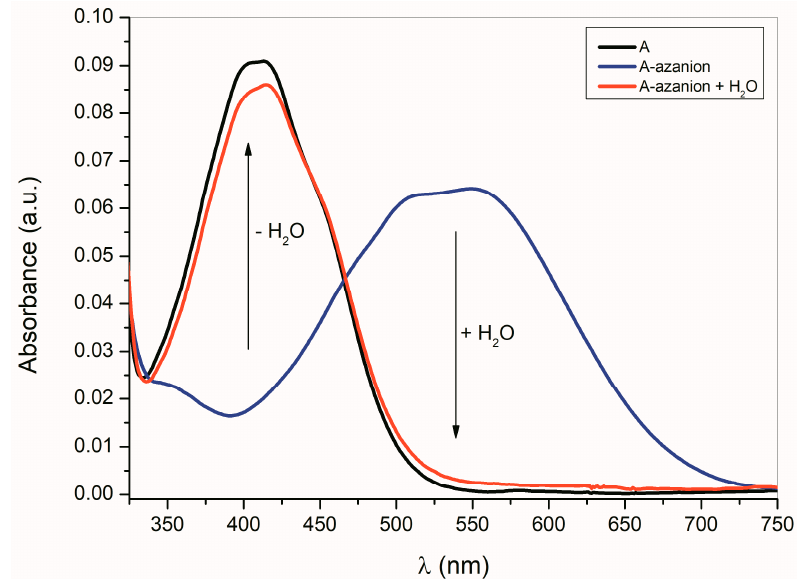
Figure 2. Effect of water (c H 2O = 1 × 1.85 mol·dm − 3 ) on A -azanion UV–Vis spectrum in acetonitrile,